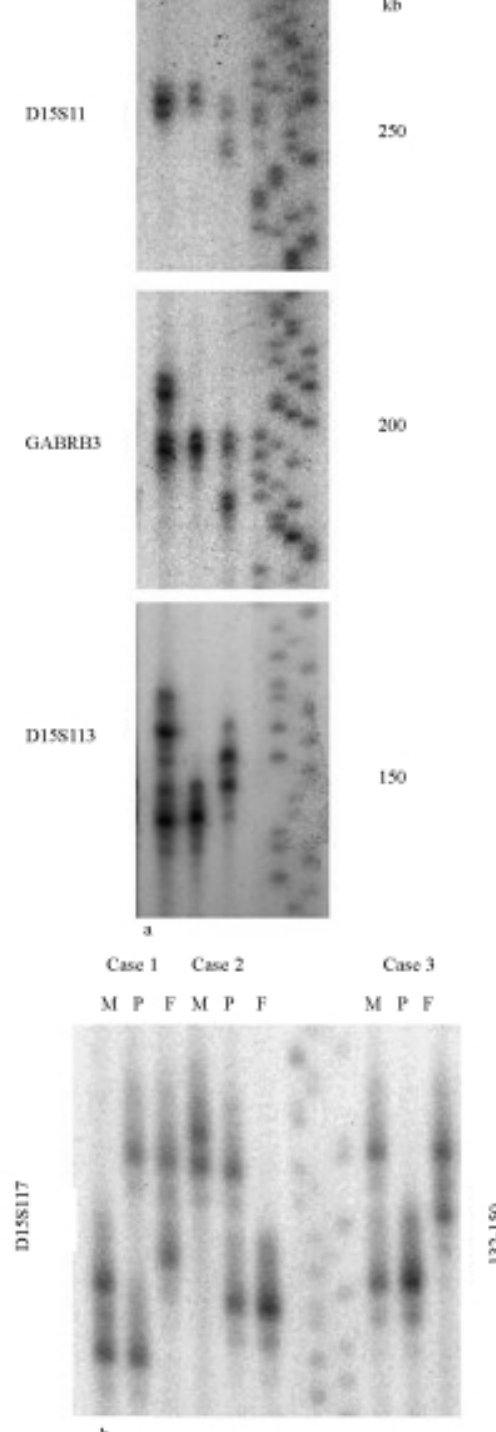
Figure 4 - Microsatellite genotyping: a) multiplex PCR of loci D15S11 , GABRB3 and D15S113; only the maternal allele is present in the patient; b) PCR of locus D15S117 mapped outside the PWS/AS region, in cases with only maternally inherited alleles mapped to 15q11-q13; cases 1 and 2 show biparental inheritance, indicating a deletion; case 3 inherited only the maternal allele, indicating a maternal UPD. M = mother, P = patient,